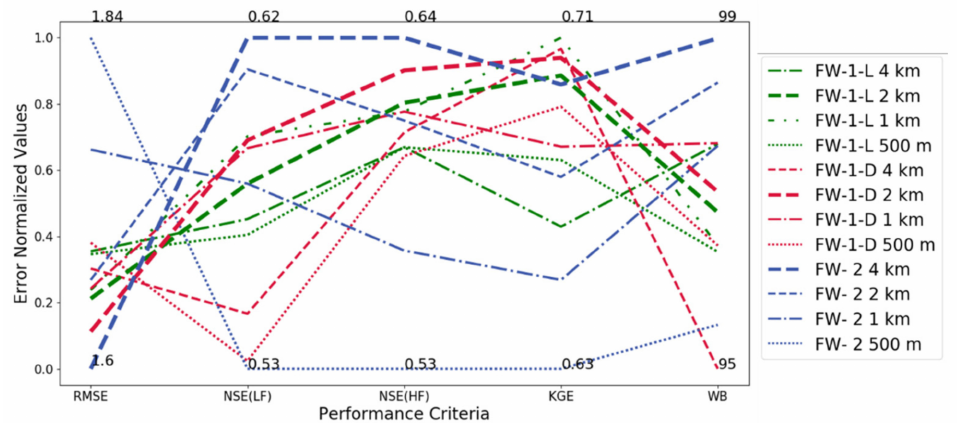
Figure 11. Normalized performance criteria for the calibration period for all distributed models. The minimum and maximum error values are presented at the top and bottom of the figure. y -axis represents the percent of model error between the maximum and minimum